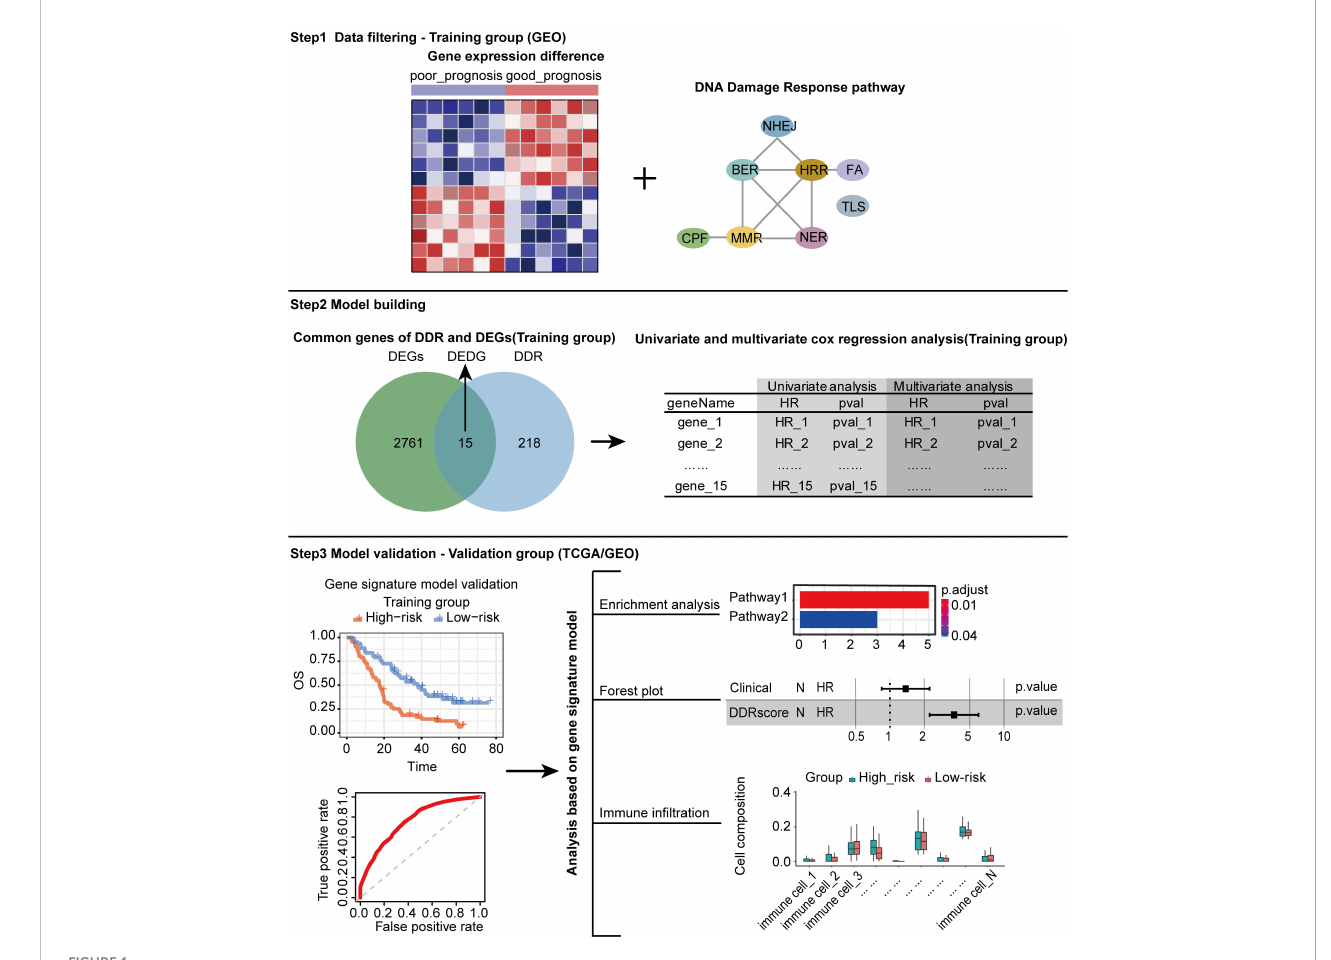
FIGURE 1 Flow chart of the analytical process in this